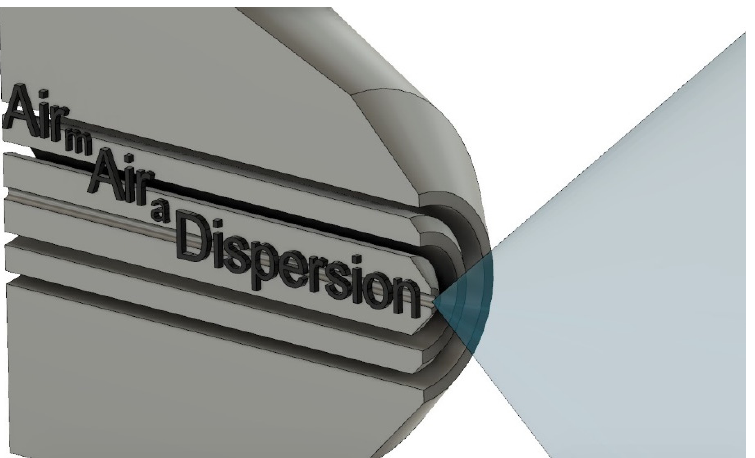
Figure 2. Schematic representation of the three-channel spray nozzle used in this study (air m = mi- croclimate air, air a = atomization air).